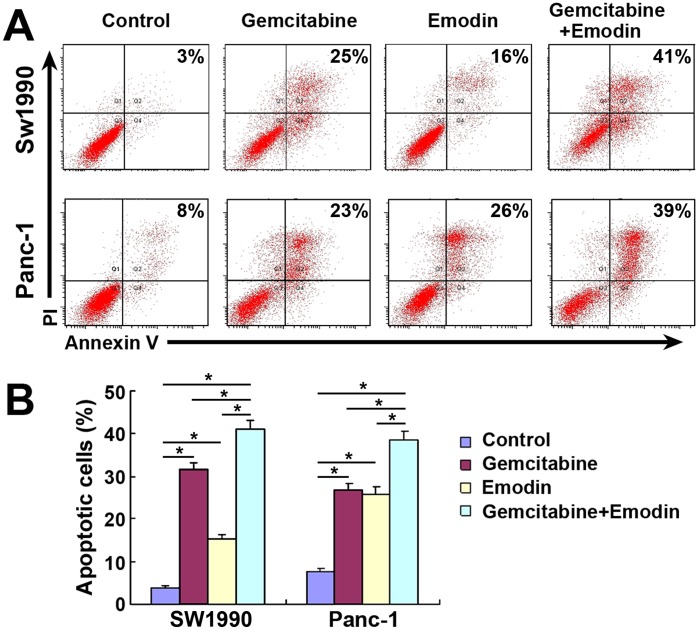
Effect of emodin on the apoptosis of pancreatic cancer cells.(A) Representative dot-plots illustrating the apoptotic status of SW1990 cells and Panc-1 cells. (B) The percentage of apoptotic SW1990 cells and Panc-1 cells. *, P<0.05.